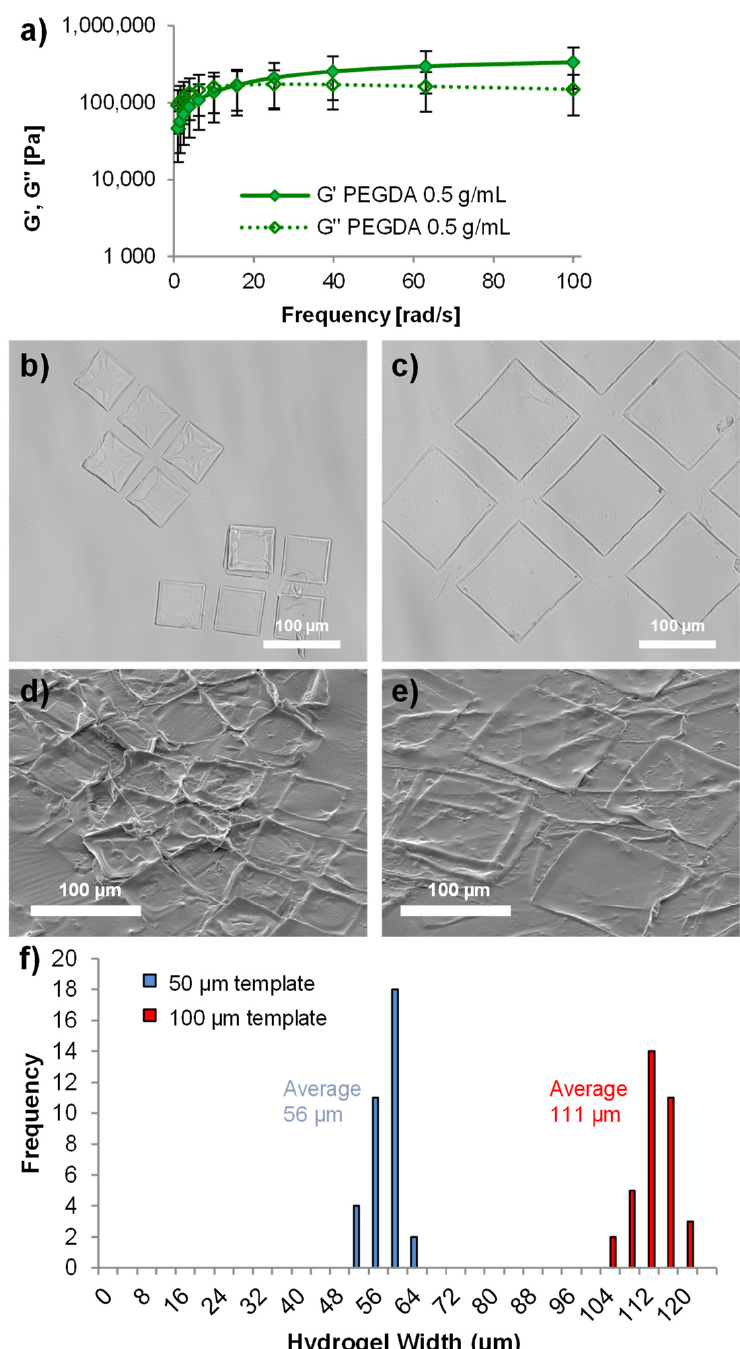
Figure 3. Characterization of the microscale hydrogels. Rheological measurements of bulk hydrogels formed from the relatively high monomer concentration used (0.5 g/mL), showing the flexibility of the hydrogels formed ( a ) ( n = 4, error bars represent ± standard deviation). Light microscope images of 50 µm hydrogels ( b ) and 100 µm hydrogels ( c ) whilst hydrated in PBS. Scanning electron microscope images of 50 µm hydrogels ( d ) and 100 µm hydrogels ( e ) whilst dehydrated under vacuum, showing that the overall shape of the material was maintained. Characterization of the size of the microscale hydrogels in PBS shows ( f ) that they had a tight size distribution and swelled to a size slightly larger than the template they were formed within. All scale bars represent 100 µm.